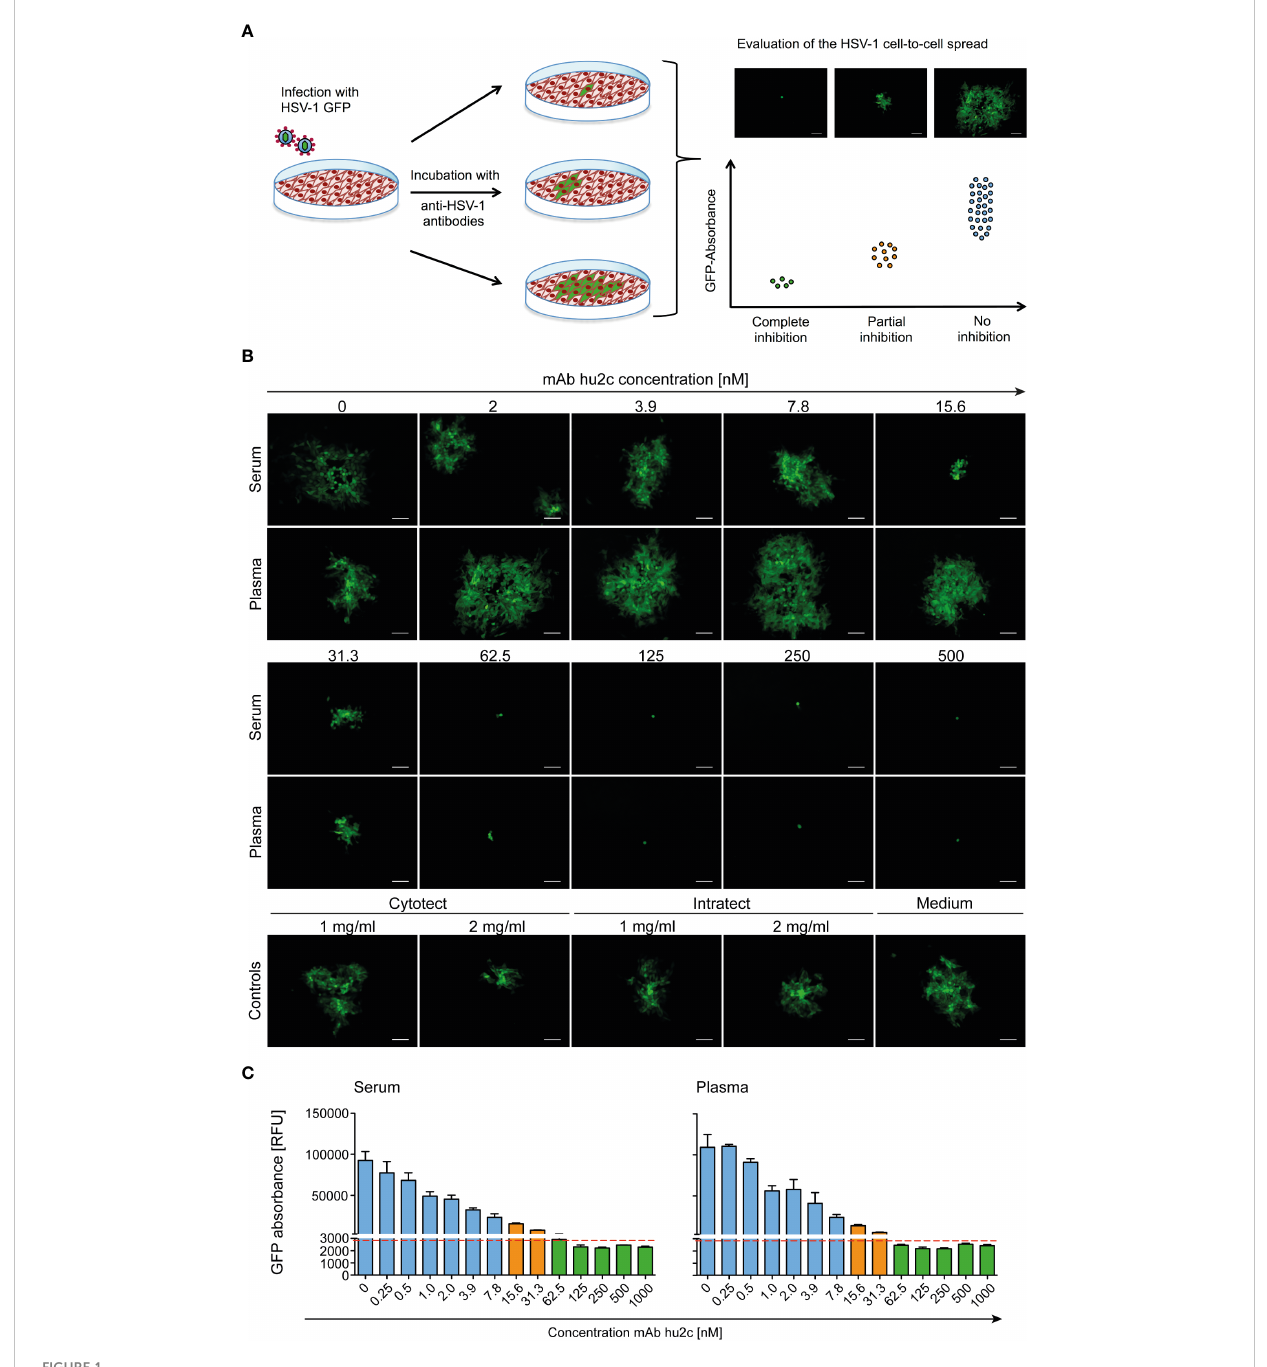
FIGURE 1 Assessment of the HSV-1 cell-to-cell spread inhibiting antibodies of human plasma, serum samples or antibodies using the HSV-1 D gE GFP reporter virus-based screening method. (A) The procedure was based on assessing the extent of plaque formation, which was proportional to the GFP-signal emitted by the infected cells. Con fl uent Vero cells were infected with HSV-1 D gE GFP reporter virus at low MOI. Infected cell cultures were overlaid with a medium containing either sera or plasma samples from HSV-seropositive humans at a 1:40 dilution. After 72 h hours of incubation, plaque formation was qualitatively assessed by fl uorescence microscopy and simultaneously the GFP-signal was quanti fi ed as relative fl uorescence units (RFU). (B) The performance of the HSV-1 D gE GFP reporter virus-based assay was evaluated for the screening of sera and plasma that contain various concentrations of HSV-1 cell-to-cell spread inhibiting antibodies. Con fl uent Vero cells growing on 24-well plates were infected with 200 TCID50/500 µl of the HSV-1 D gE GFP reporter virus. After 2 h of incubation, the inoculating medium was removed and the cells were overlaid with a medium containing sera or plasma from a HSV-1 seronegative donor at a 1:40 dilution. Additionally, the monoclonal, HSV-1/2 cell-to-cell spread inhibiting antibody mAb hu2c was added at a fi nal concentration ranging from 0 to 1000 nM. After 72 h hours, plaque formation, which indicates HSV-1 spread via the cell-to-cell spread, was qualitatively assessed by fl uorescence microscopy. 100x magni fi cation, scale bar = 100 µm. (C) Additionally, the cell cultures were transferred to 96-well plates to quantify the GFP-signal as relative fl uorescence units (RFU). Dashed line = cell-to-cell spread inhibiting concentration of mAb hu2c. Green bars = complete inhibition, orange = partial inhibition, blue = no inhibition of HSV-1 cell-to-cell